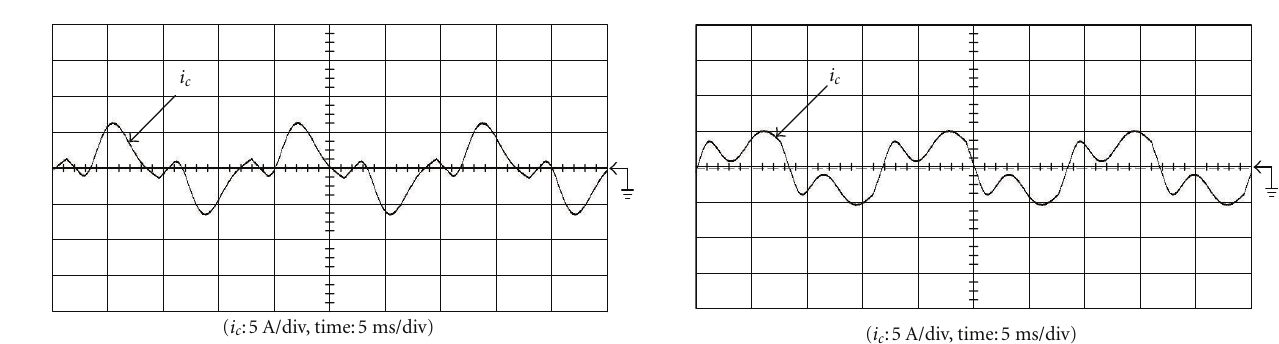
Figure 21: The corresponding inverter current during the interval of low insolation.